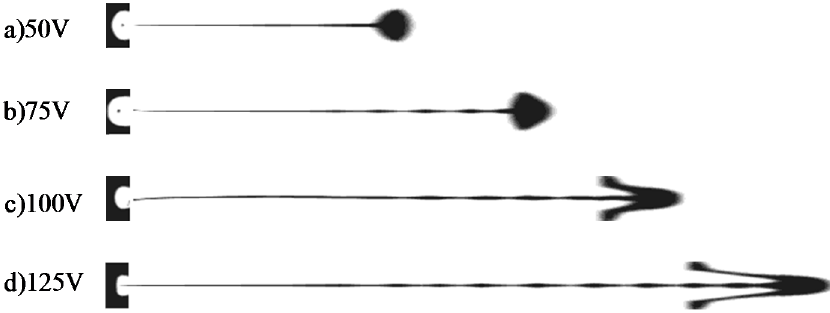
Figure 10. The dispersion conditions of the droplets with different amplitudes.